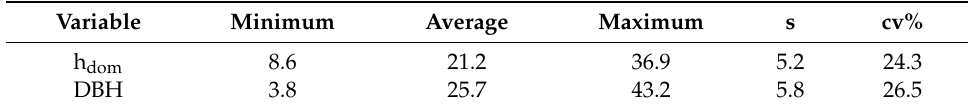
Table 2. Descriptive statistics of variables used in modelling of h dom for Ochroma pyramidale (balsa-tree) stands in Ecuador.